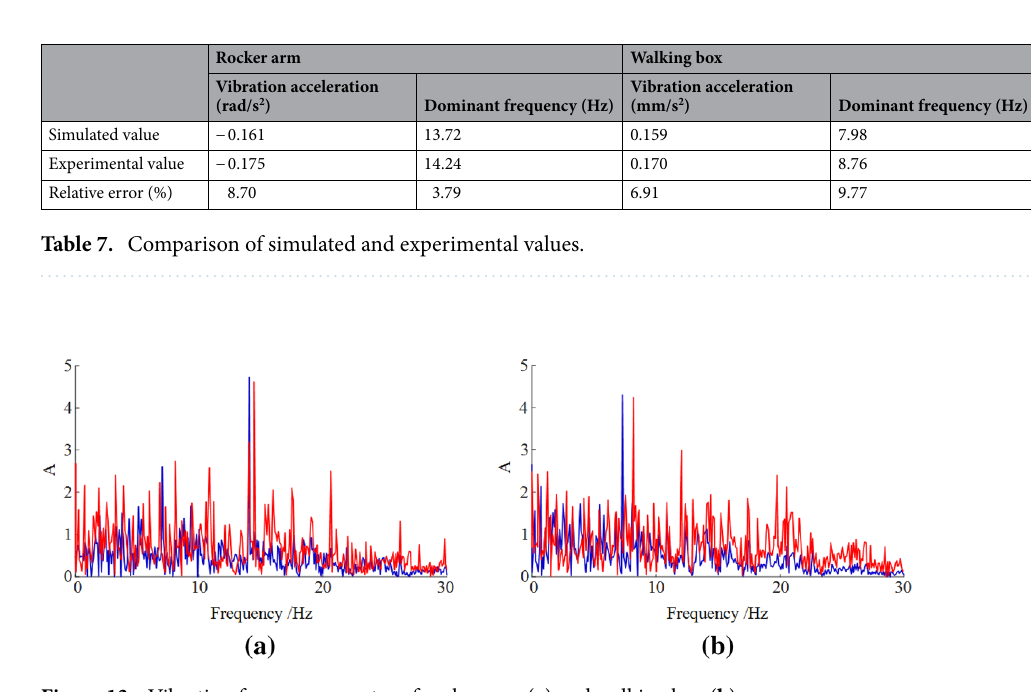
Figure 13. Vibration frequency spectra of rocker arm ( a ) and walking box ( b